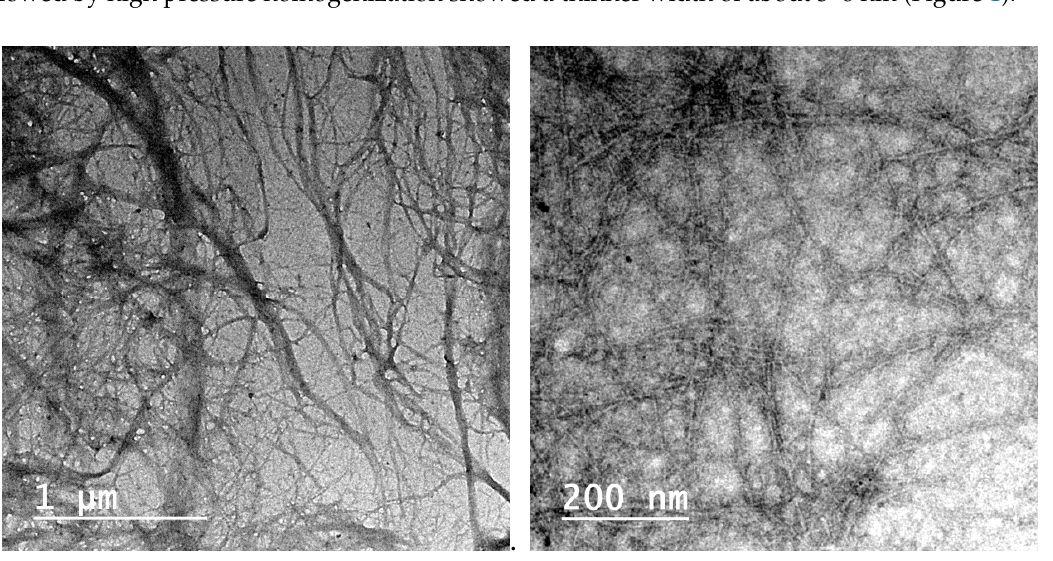
Figure 1. TEM of CNF ( left ) and TEMPO-oxidized CNF ( right ) isolated from date palm fruit stalks